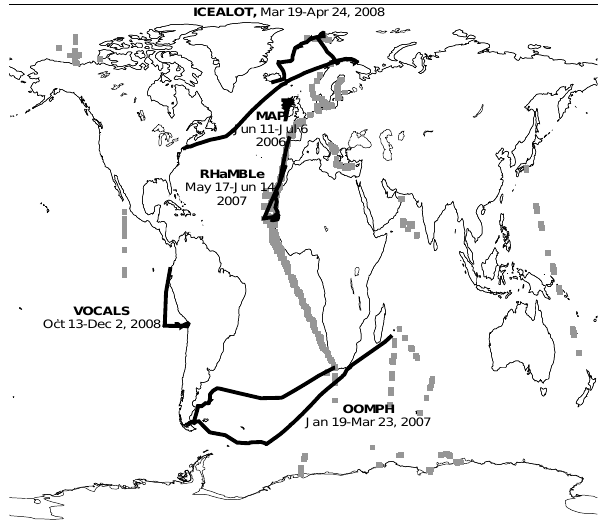
the model is made up of hydrophilic OM. Spracklen et al.